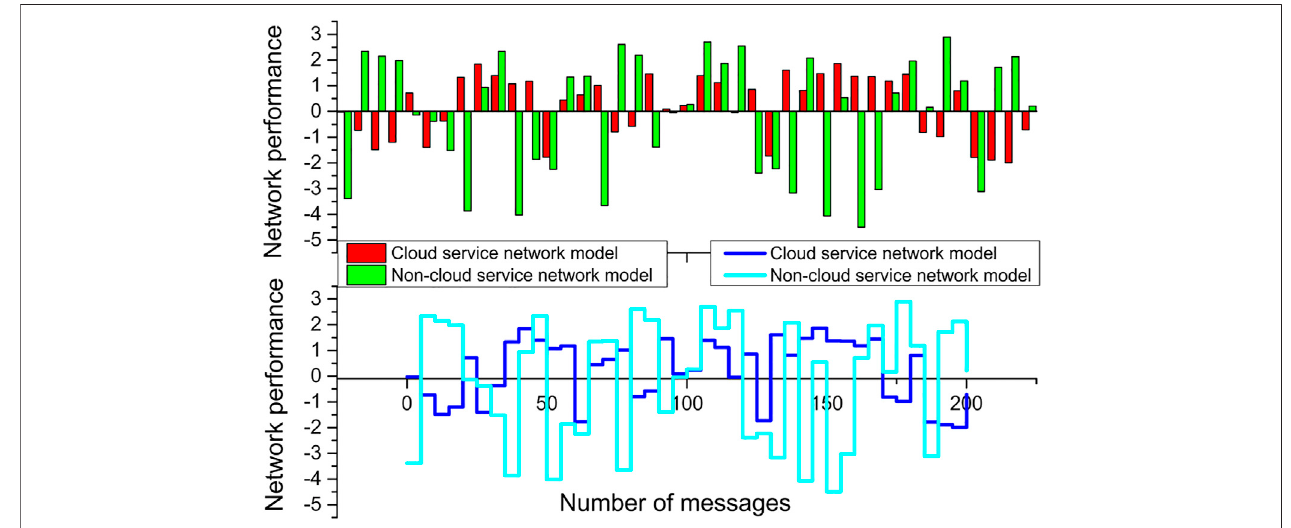
FIGURE 11 | Network jitter analysis and comparison.